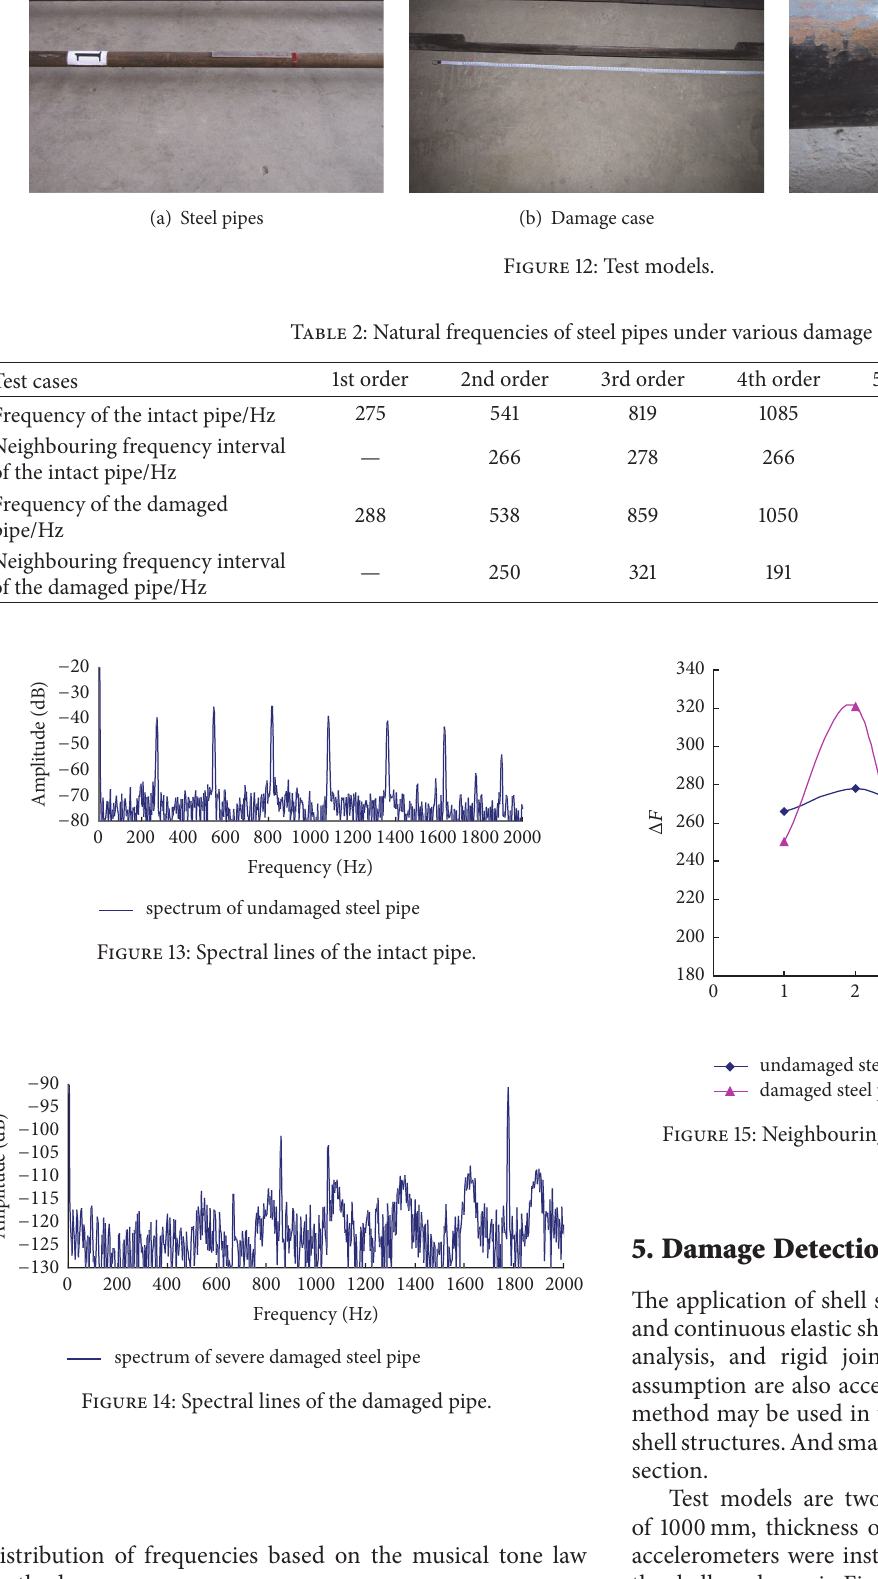
distribution of frequencies based on the musical tone law method.